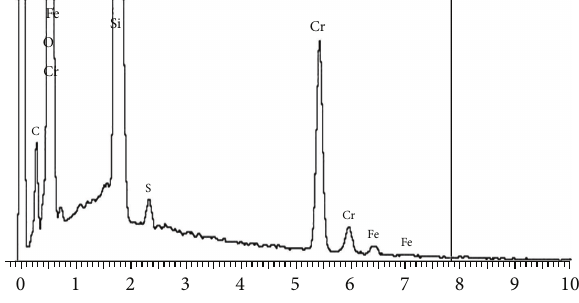
Figure 5: EDX spectrum of nimesulide/silica aerogel.